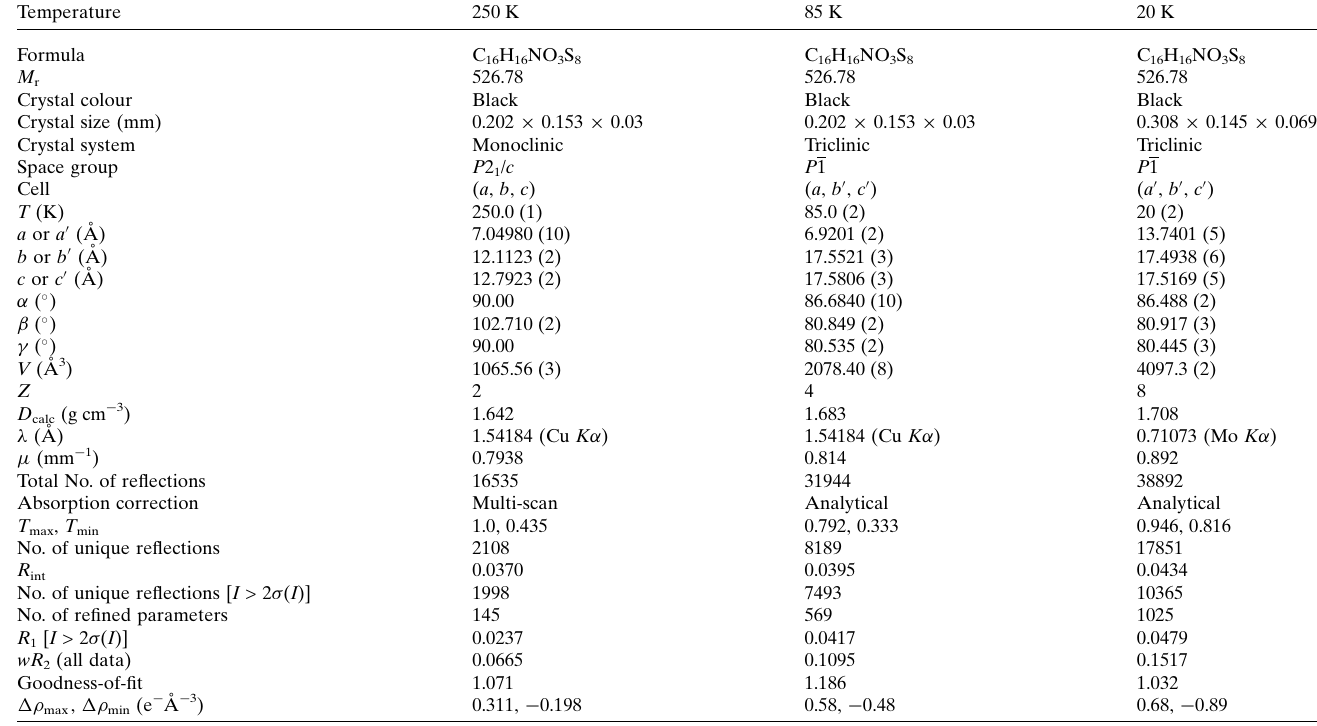
Table 1 Crystallographic data for ( o -Me 2 TTF) 2 NO 3 at different temperatures.